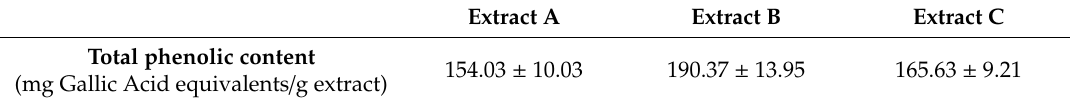
Table 3. Total phenolic content estimation of G. glabra L. leaf extracts. Extract